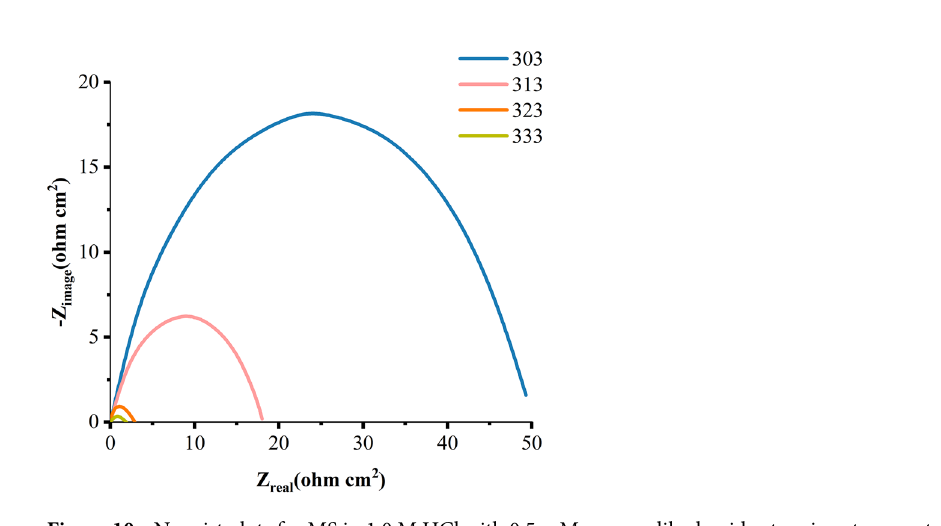
Figure 10. Nyquist plots for MS in 1.0 M HCl with 0.5 mM nonanedihydrazide at various temperatures.